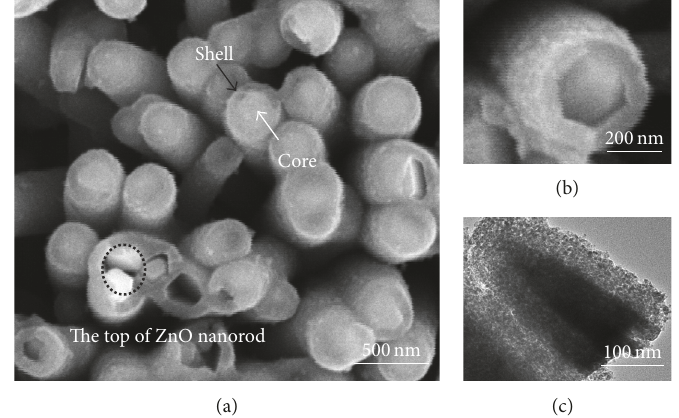
Figure 2: High resolution SEM ((a) and (b)) and TEM (c) of ZnO@TiO 2